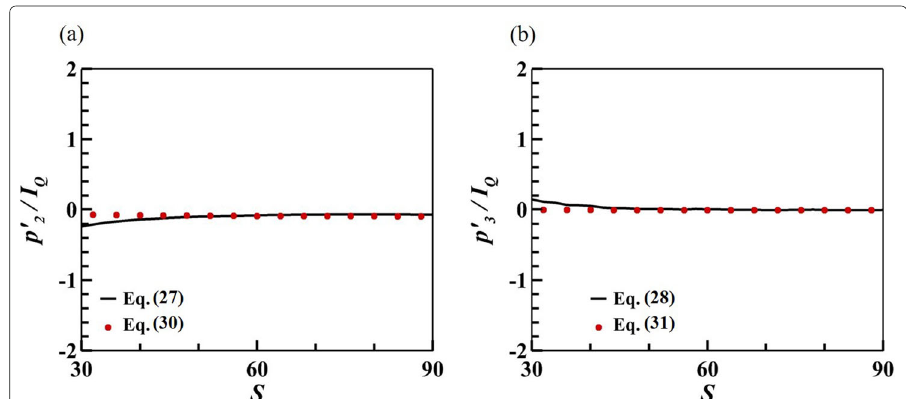
Fig. 7 Sound pressures correspond to ( a ) the second term and ( b ) the third term at different observer distances S . The sound pressures corresponding to the second term are computed by using the Eqs. (27) and (30), respectively. The sound pressures corresponding to the third term are computed by using the Eqs. (28) and (31), respectively. The sound pressures at the non-time dimensional time t = 120 are plotted. The convecting Mach number of the vortex is M a = 0.2 and the observers are distributed along the line with θ = 45 ◦